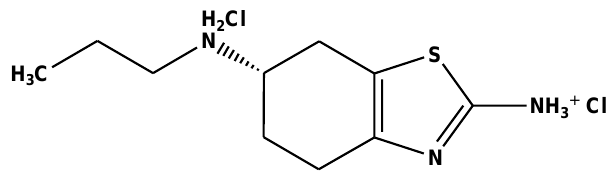
Figure 9. Schematic of the chemical structure of pramipexole dihydrochloride. Pramipexole dihydrochloride [(6S)- N